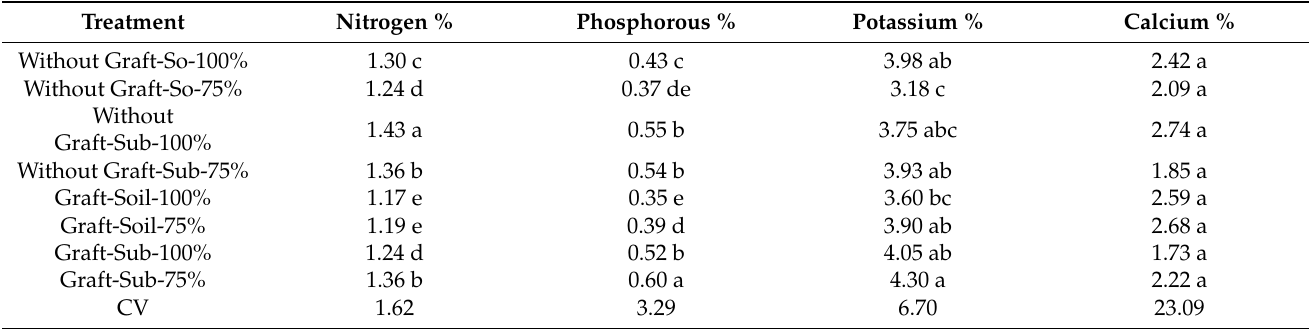
Table 3. Comparison of means of treatments in the mineral content of the